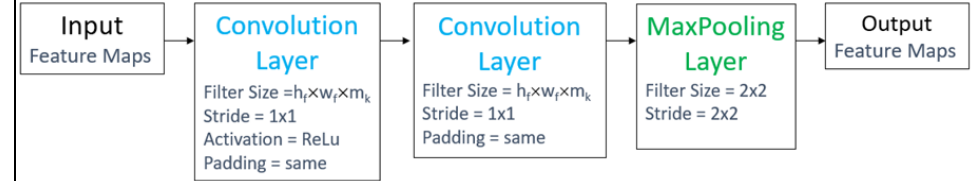
Figure 7. RI-Conv block flowchart.